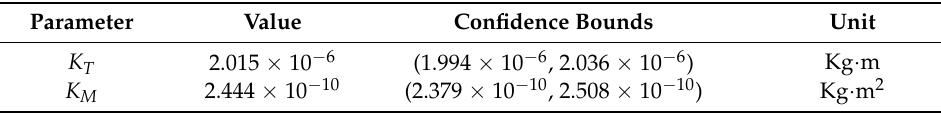
Figure 12. Thrust and torque generated by propeller as a function of rotating speed: ( a ) thrust curve; ( b ) torque curve. ( b ) torque curve. Table 4. Test and fitting results of the propeller. Table 4. Test and fitting results of the